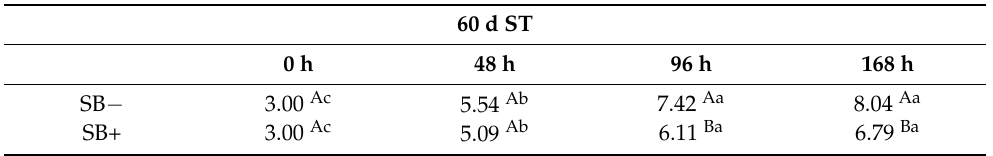
Table 7. The effects of the additive application and aerobic exposure time interaction (SB × AE) on yeast count (cfu · g − 1 ) in sugarcane